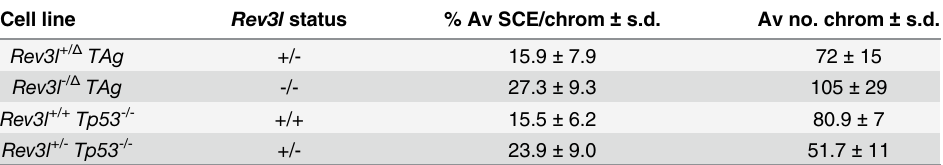
Table 1. Sister Chromatid Exchange (SCE) frequency in immortalized MEF cell lines. Cell line Rev3l status % Av SCE/chrom ± s.d. Av no. chrom ± s.d. Rev3l +/ Δ TAg +/- 15.9 ± 7.9 72 ± 15 Rev3l -/ Δ TAg -/- 27.3 ± 9.3 105 ± 29 Rev3l +/+ Tp53 -/- +/+ 15.5 ± 6.2 80.9 ± 7 Rev3l +/- Tp53 -/- +/- 23.9 ± 9.0 51.7 ± 11 SCE frequencies are given as the average number per chromosome (total SCE observed / total chromsomes counted). For each cell line, 30 – 35 metaphases were scored. All cell lines were polyploid, as is commonly observed following immortalization. One MEF cell line pair was derived from p53-defective embryos and were described by Wittschieben et al . [9]; these are the Rev3l +/+ Tp53 -/- B2 cell line and